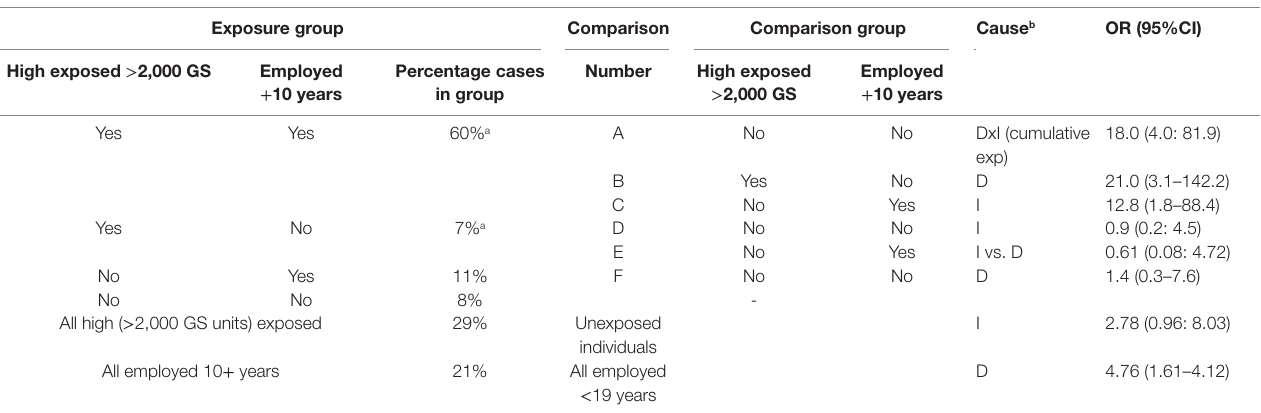
TABLe 2 | Re-analysis Table iv in Milham and Morgan